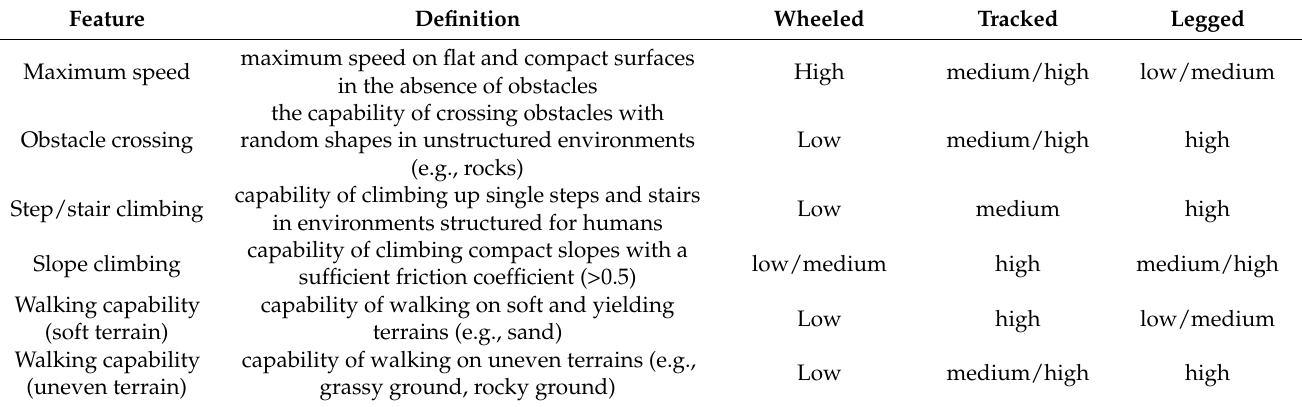
Table 3. Locomotion feature comparison of ground vehicles (NA: Not